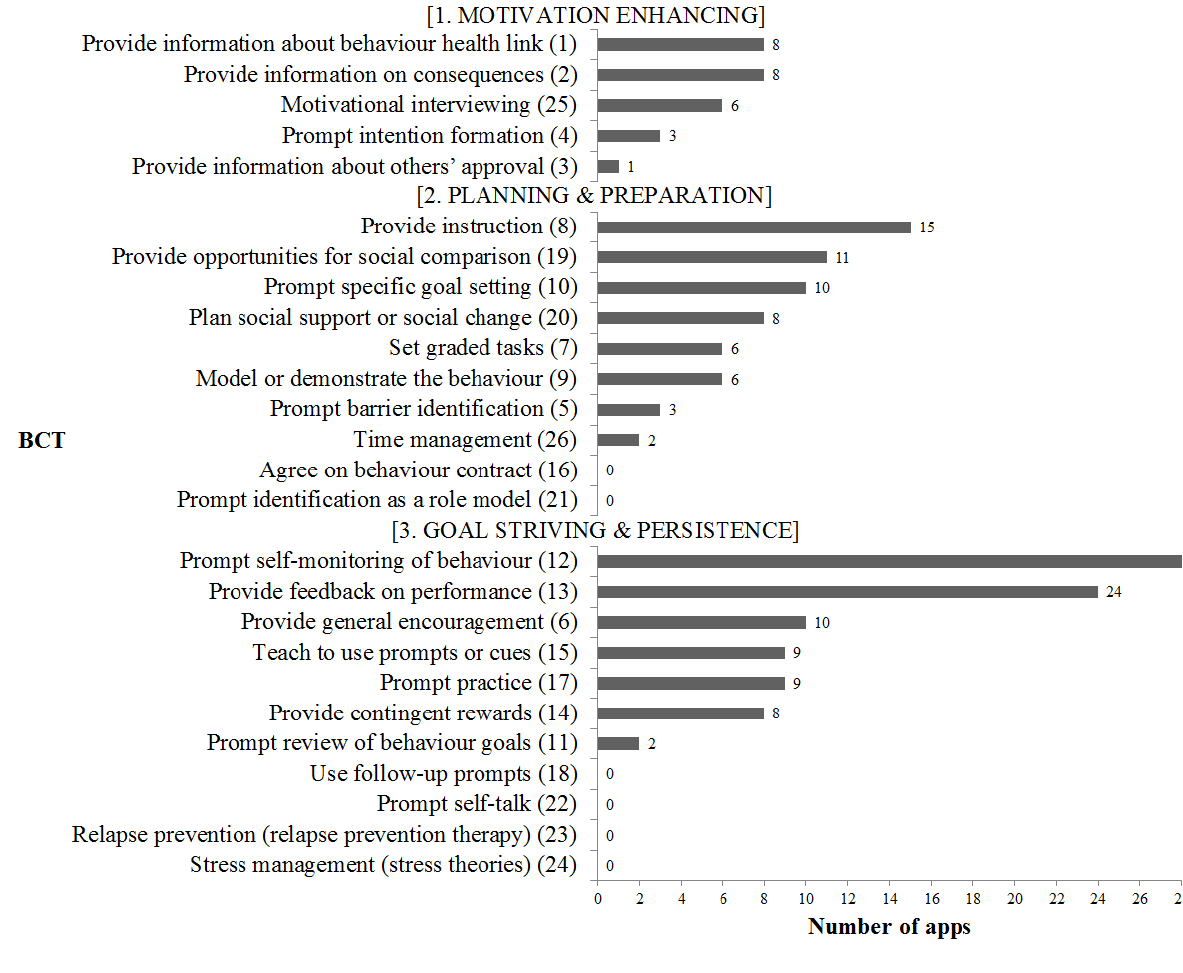
Figure 7. Incorporation of behavior change techniques (BCTs) across apps. Number of apps (n=28) incorporating each of the 26 individual BCTs according to the three-phase categories: motivation enhancing, planning and preparation, and goal striving and